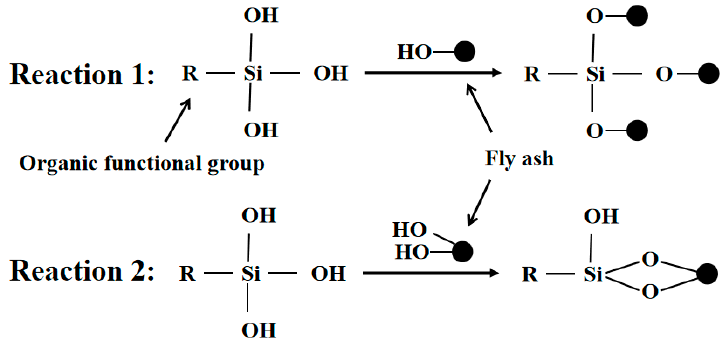
Figure 7. Hydrolysis process of HDTMS [18].